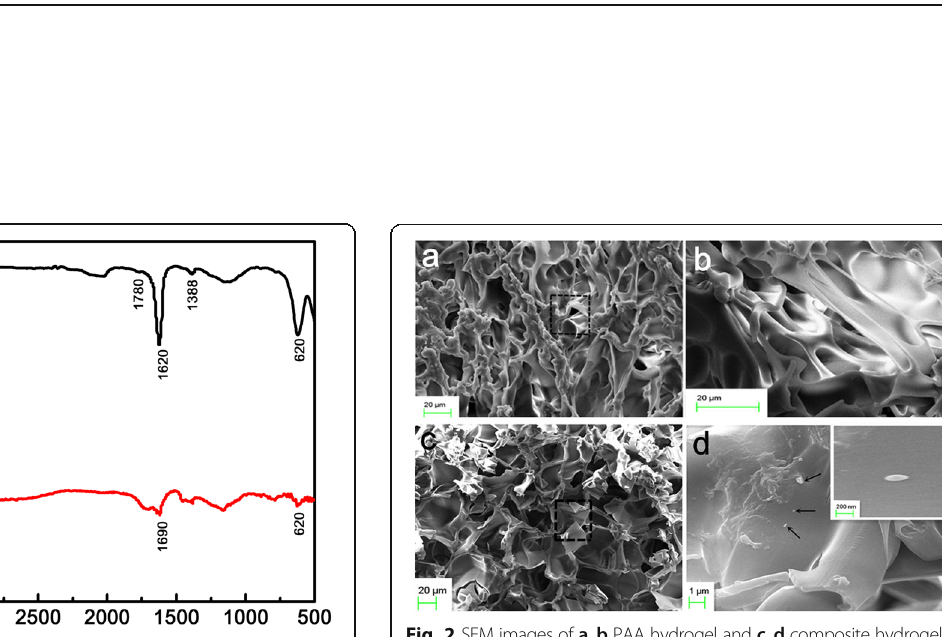
Fig. 2 SEM images of a , b PAA hydrogel and c , d composite hydrogel. The BNNS-NH 2 was pointed out by arrows in ( d ), and the inserted image in ( d ) is the zoomed-in image of the BNNS-NH